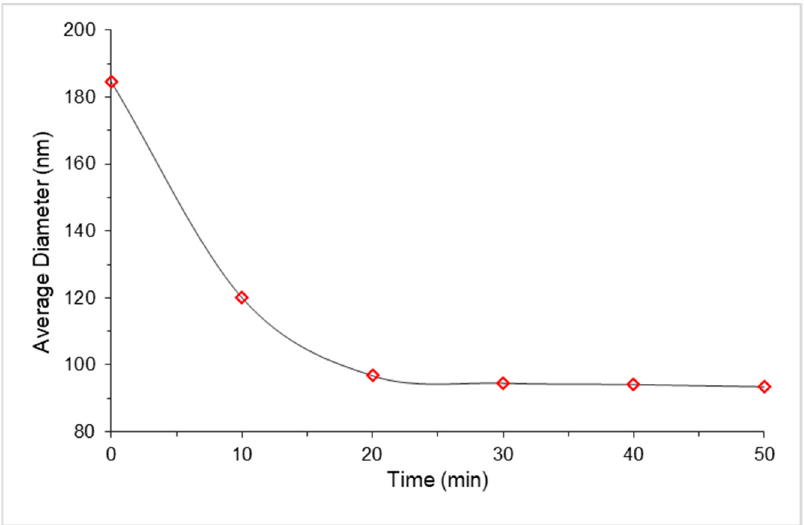
Figure 8. UV-vis spectra of IgG loaded AZP nanosphere dispersion post-irradiation at different time points.